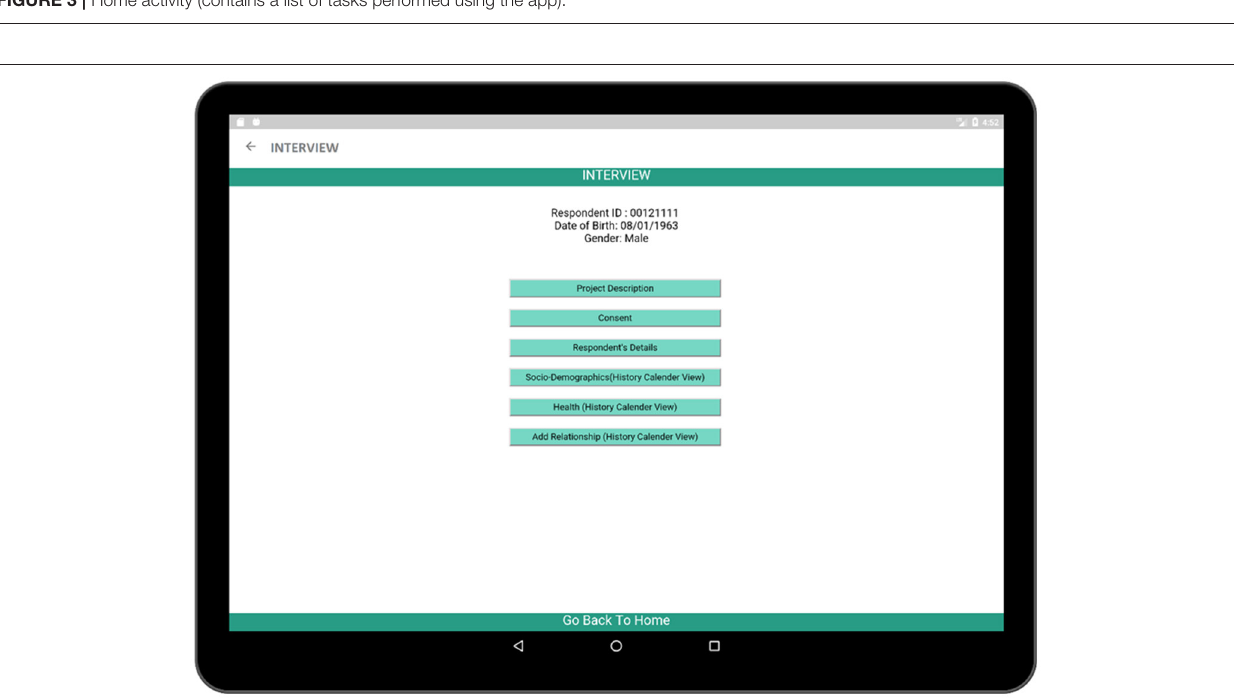
FIGURE 4 | INTERVIEW activity (contains the necessary steps which are necessary to complete the